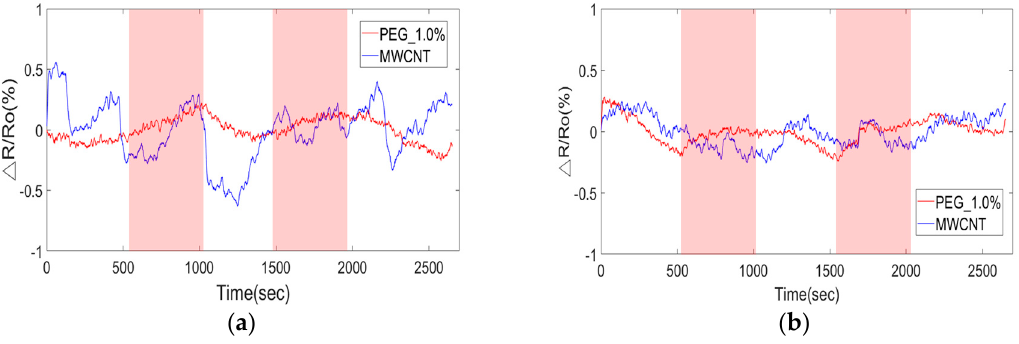
Figure 11. Sensor response of 1.0% PEG and MWCNTs at ( a ) Room temperature and ( b ) 50 °C.